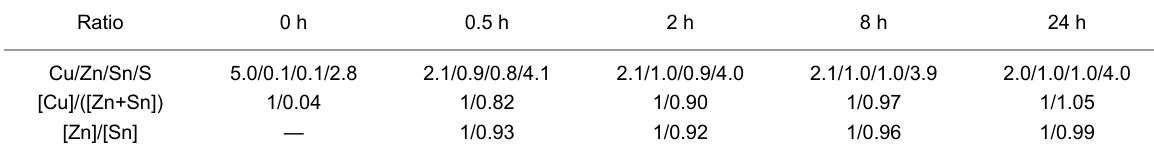
Table 2: Quantitative elemental analysis of CZTS nanocrystals synthesized at different reaction duration.